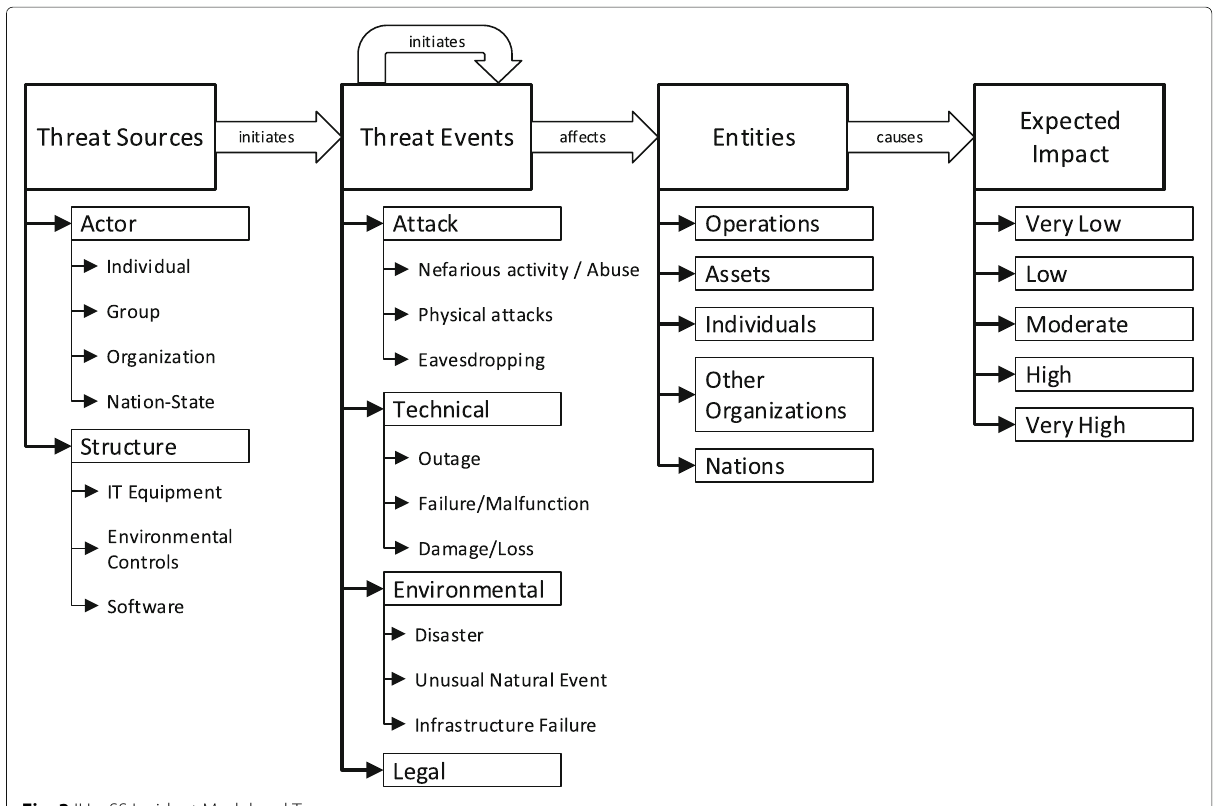
Fig. 3 IHaaSS Incident Model and